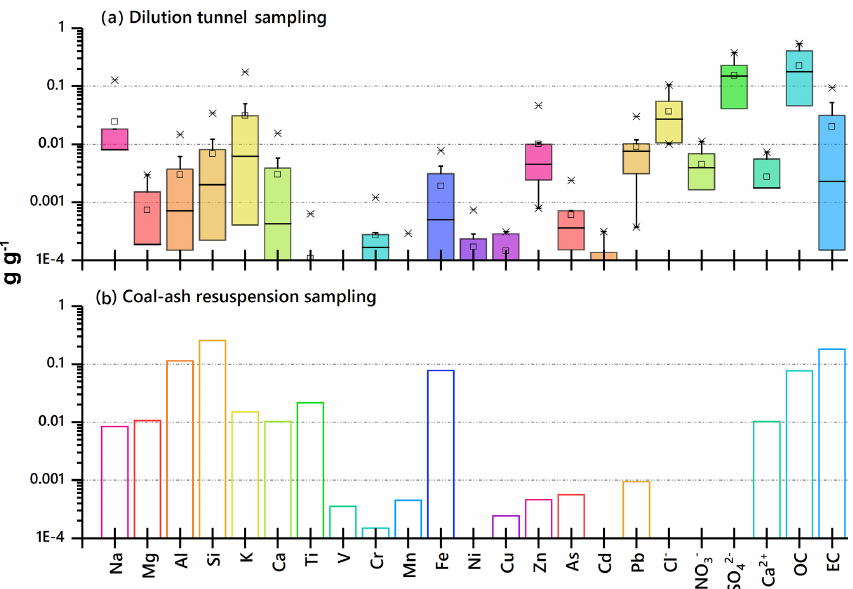
Figure 6. RCC profiles of PM 2 . 5 collected using the DTSM with ( a ) data collected from available published profiles (Ge et al., 2004; Kong, 2014; Liu et al., 2016, 2017; Yan et al., 2017a; Dai et al., 2019), and the coal fly ash RSM with ( b ) data collected from Wang et al.,